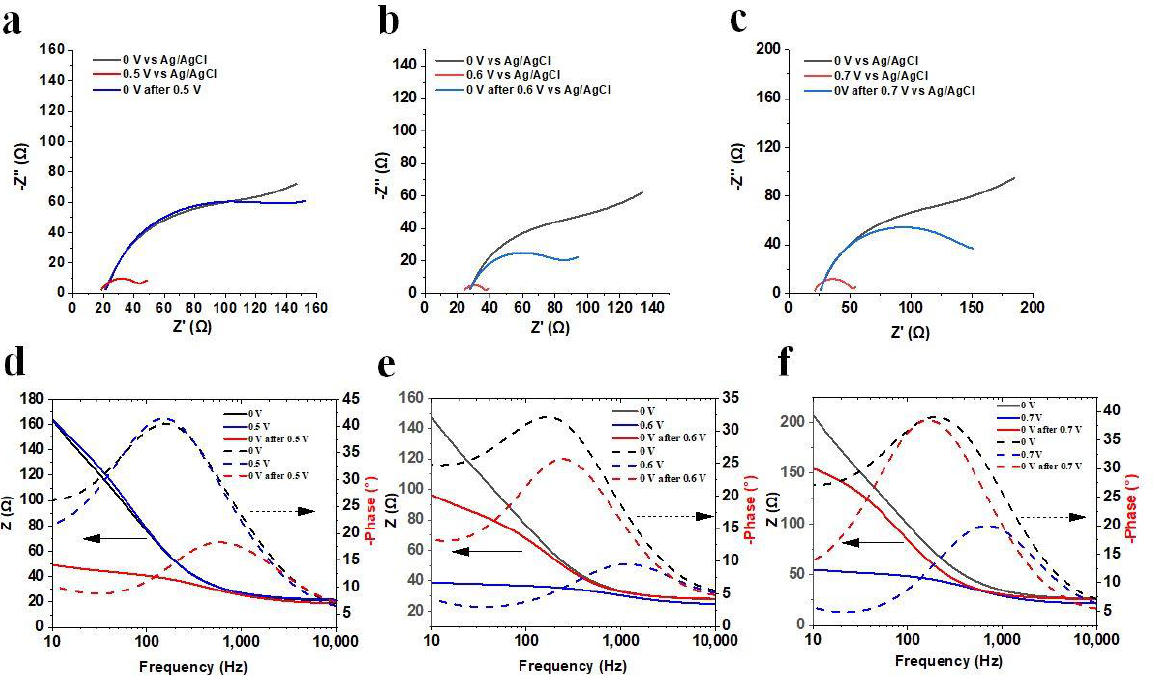
Figure 6. EIS in the form of Nyquist plots ( a – c ) and corresponding Bode plots (dashed line) with total impedance vs. frequency (solid line) ( d – f ) of PNaSS@PEDOT microspheres with E. coli at different applied potentials.